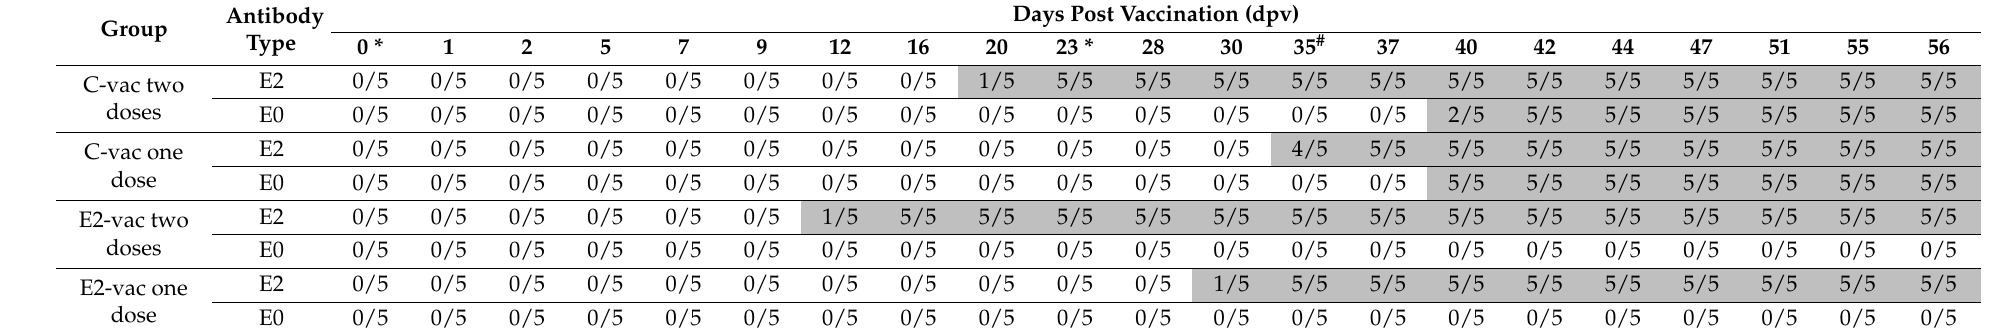
Gray shading: at least one antibody-positive piglet. *: The day with